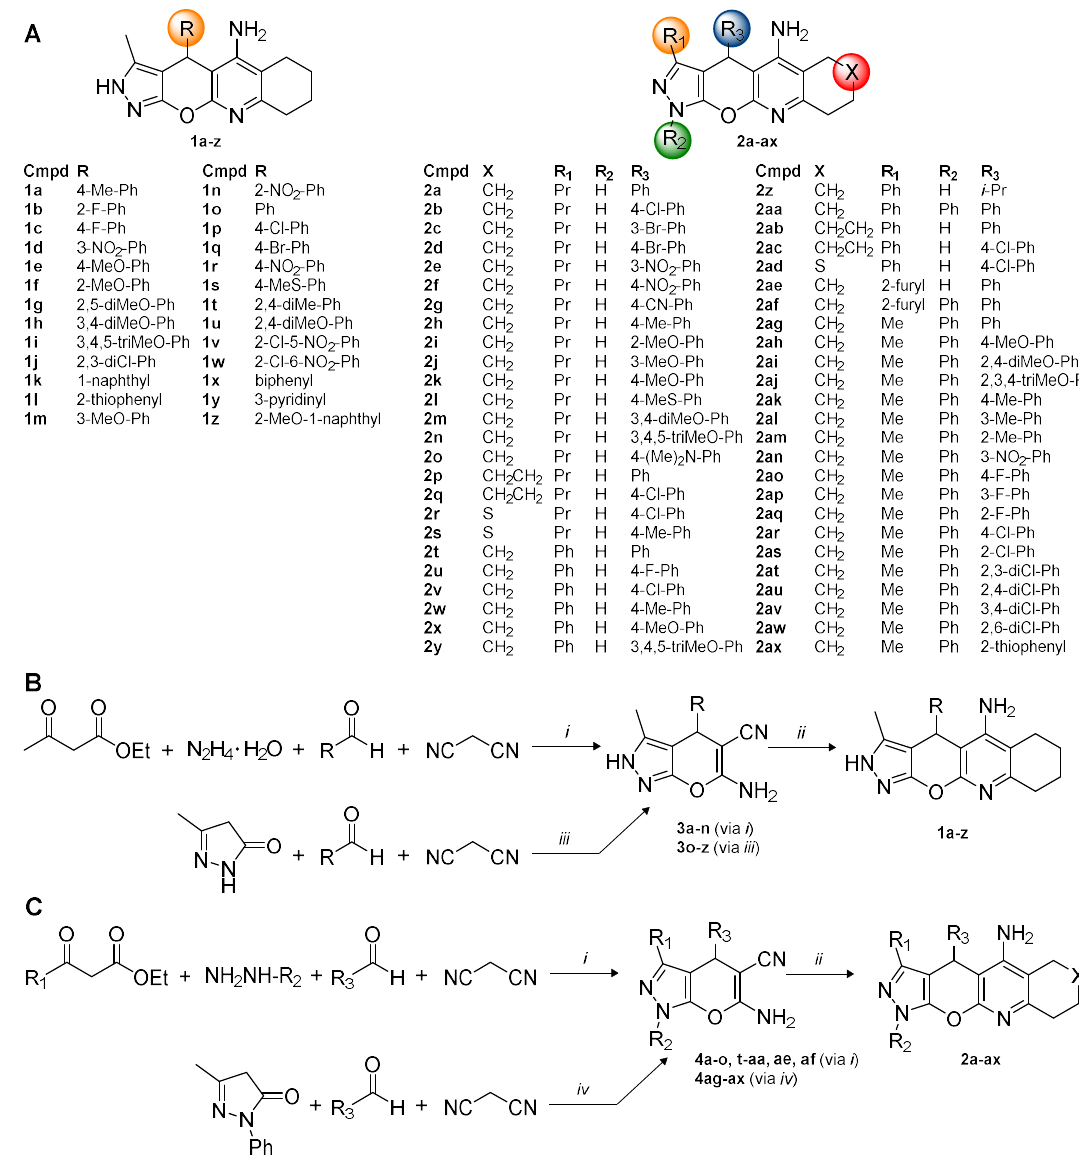
IC 50 = 18 µ M), while 2u showed no inhibition of this enzyme, and both 2u and 2x were less hepatotoxic than tacrine, showing no appreciable change in the HepG2 cell viability up to 50 µ M [66]. Compounds 2ag – ax were overall less potent inhibitors of AChE. Of this series, 2ag and 2ah with a phenyl and 4-methoxyphenyl substituent o ff the pyran, respectively, showed the best inhibition of Ee AChE